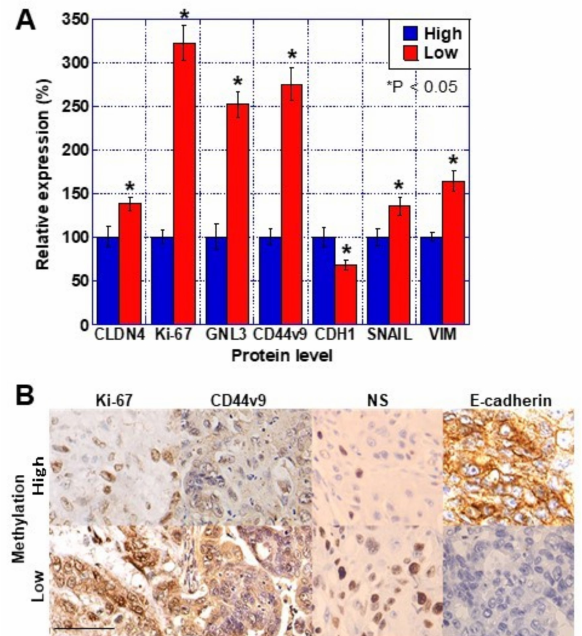
Figure 2. Levels of malignant phenotype-associated proteins in 23 cases of BUCs. Protein expression in the 23 BUC cases shown in Table 2 (11 high-methylation and 12 low-methylation cases) were examined by ( A ) ELISA and ( B ) immunohistochemistry. Relative protein levels of CLDN4, Ki-67 (proliferation), GNL3 and CD44v9 (stemness), and CDH1, SNAIL, and vimentin (EMT). Error bar indicates the SD calculated by Student’s t -test. Scale bar, 50 µ m. CLDN, claudin; BUC,